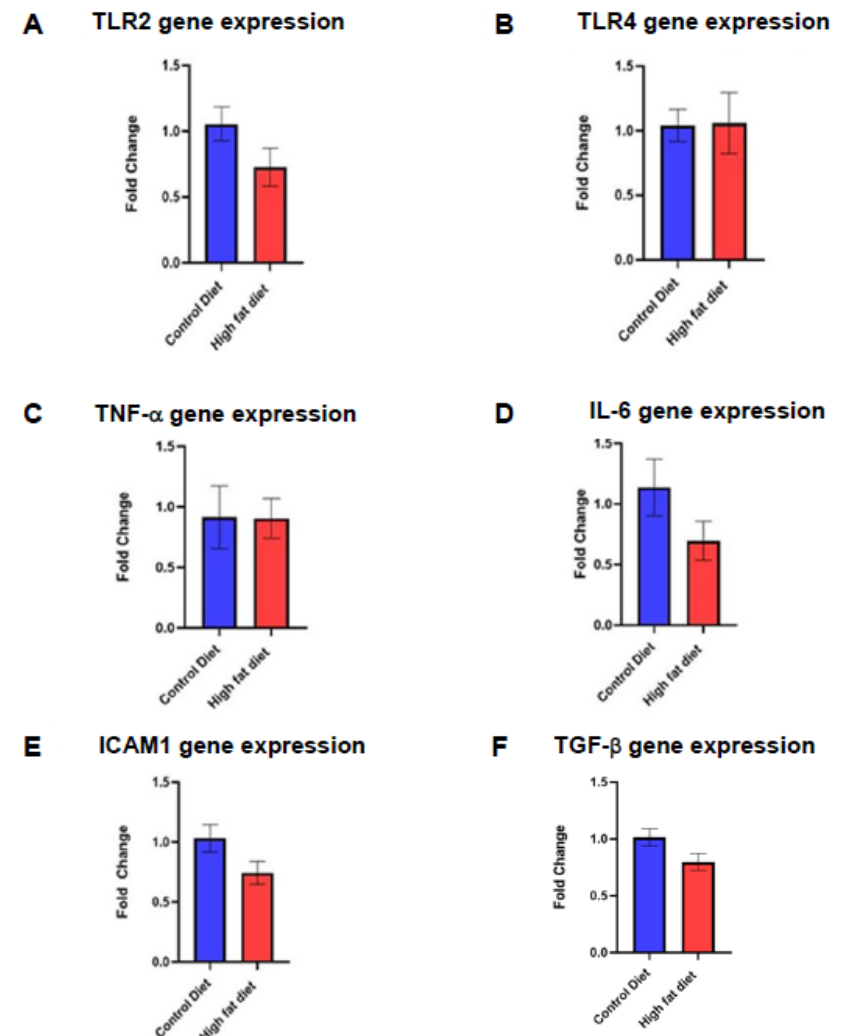
Figure 5. Quantitative gene expression studies in the mouse cochlea (qRT-PCR). ( A – F ) Gene expression levels of toll-like receptors (TLR2, TLR4), inflammatory cytokines (TNF- α , IL-6), adhesion molecule ICAM1, and anti-inflammatory mediator TGF- β were compared in mice on a high-fat diet (HFD) and control diet (CD). There were no significant differences in the gene expression of these mediators between HFD and CD mice. Data presented as mean ± SEM ( n = 6 per diet